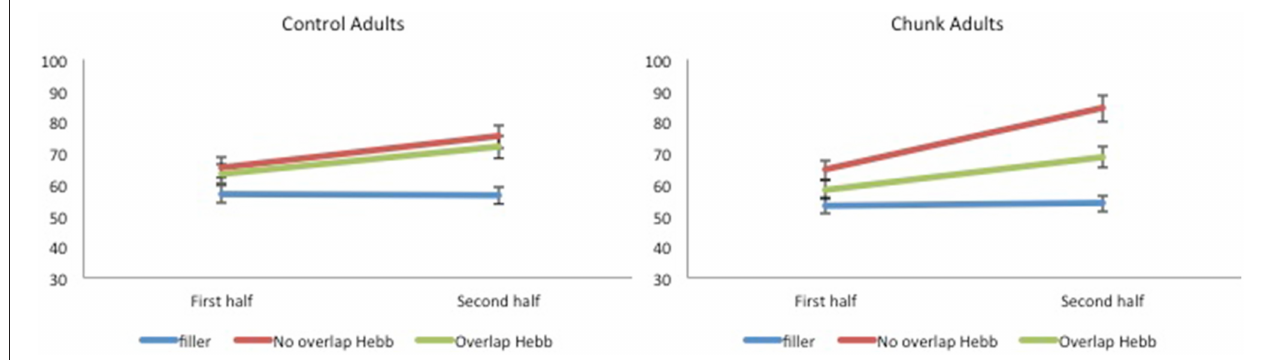
FIGURE 7 | Mean percentage of items correctly recalled (with standard errors) for Hebb and filler sequences by sequence Halves, in both control and chunk adults, Experiment 3. Left panel: performance for control adults. Right panel : performance for chunk adults.